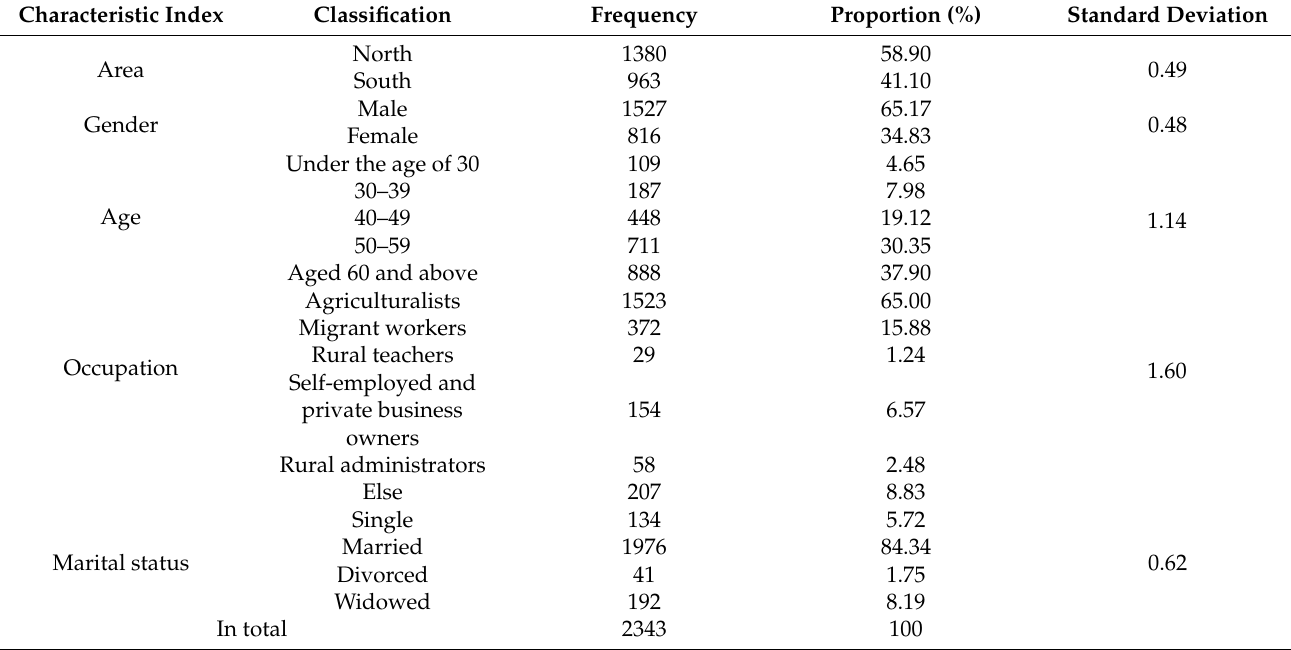
Table 2. Characteristics of the survey